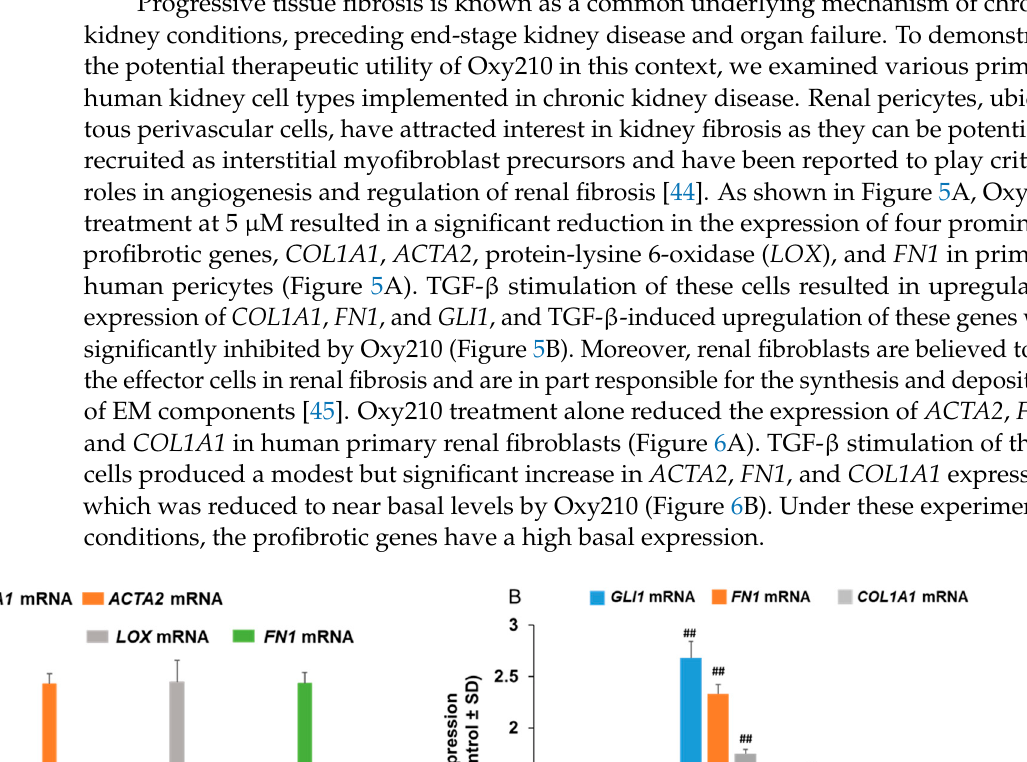
Figure 6. Inhibition of basal and TGF- β -induced expression of fibrotic genes in human renal fibroblast cells by Oxy210. ( A ) human renal fibroblast cells were treated with Oxy210 in DMEM containing 1% FBS for 48 h and then RNA was extracted and analyzed by Q-RT-PCR for the expres- sion of the genes and normalized to GAPDH expression. Data from a representative experiment are reported as the mean of triplicate determinations ± SD (** p < 0.01 vs. control). ( B ) Human renal fibroblast cells were pretreated with Oxy210 in DMEM containing 1% FBS for 2 h and then treated with TGF- β 1 (10 ng/mL) in the absence or presence of Oxy210 for 48 h. RNA was extracted and analyzed by Q-RT-PCR for the expression of the genes and normalized to GAPDH expression. Data from a representative experiment are reported as the mean of triplicate determinations ± SD (## p < 0.01 vs. control; ** p < 0.01 vs. TGF- β ).